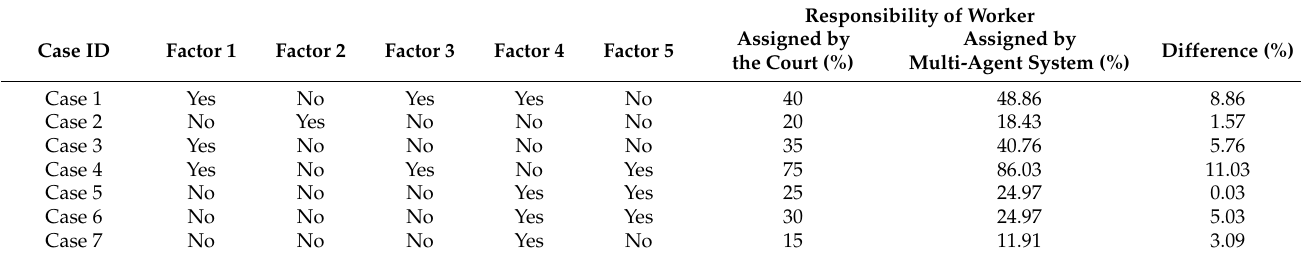
Table 7. Performance